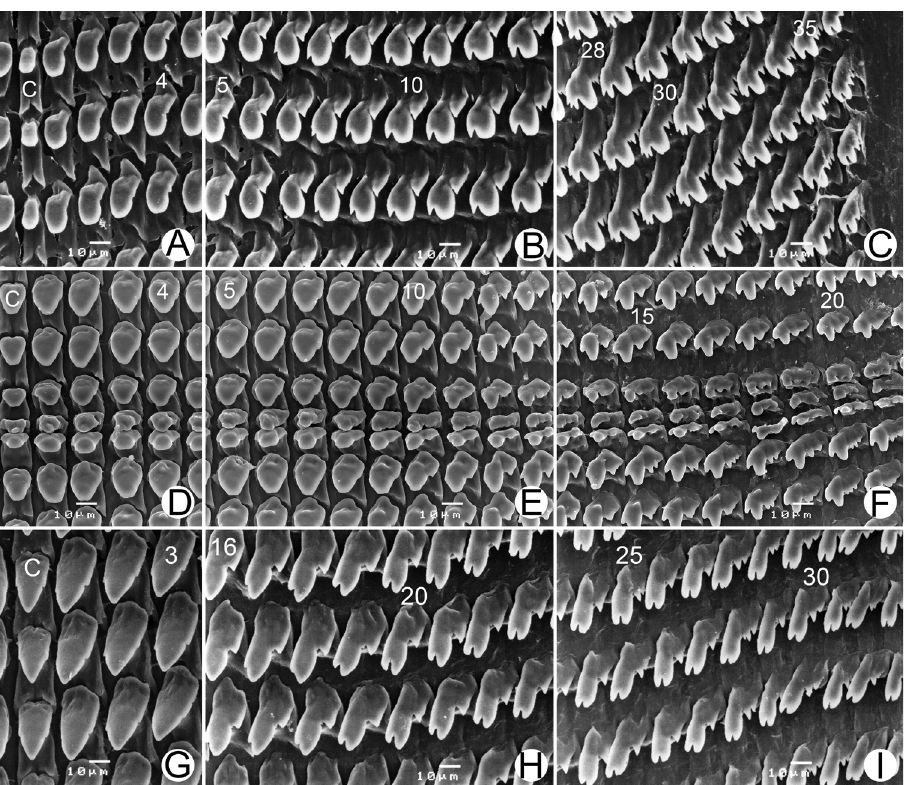
Figure 7. Radula. A–C Ganesella carinella D–F Ganesella rhombostoma and G–I Globotrochus onestera A, D, G central tooth with the first to the second lateral teeth B, E, H lateral teeth with the tricuspid marginal teeth transition C, F, I outermost marginal teeth. Numbers indicate order of lateral and marginal teeth. Central tooth indicated by late. Hermaphroditic duct (hd) convoluted and located between hermaphrodic gland (hg) (Fig. 6A).